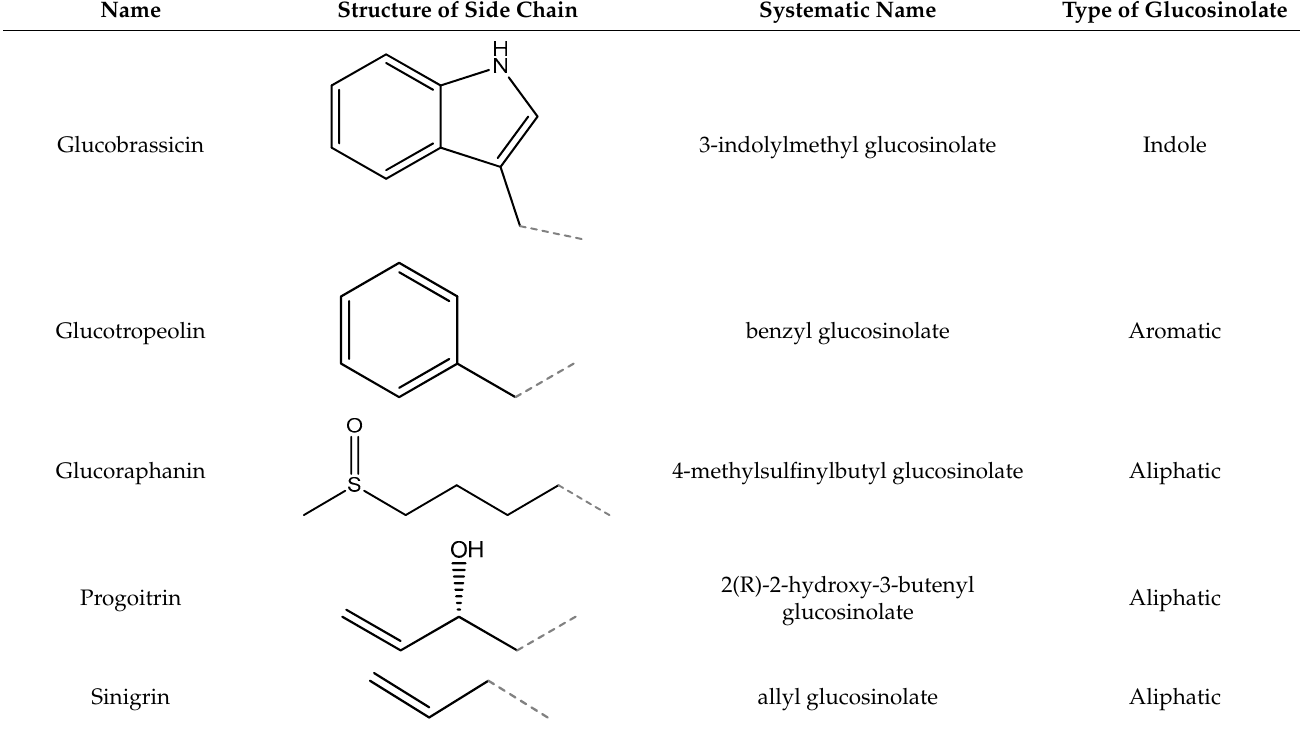
Table 2. Chemical structure of glucosinolate side chain [43,44].